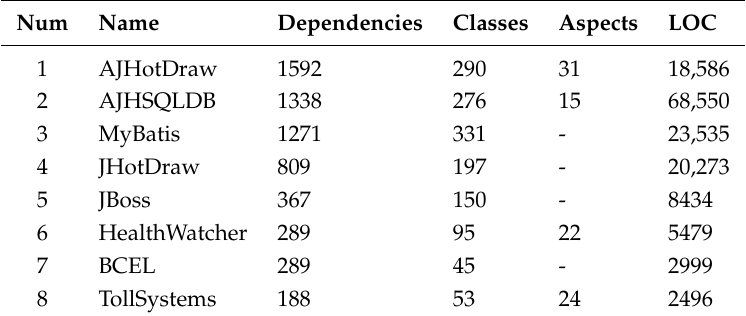
Table 1. Eight real-world problem instances (systems) for the ITO problem used in the experiments.